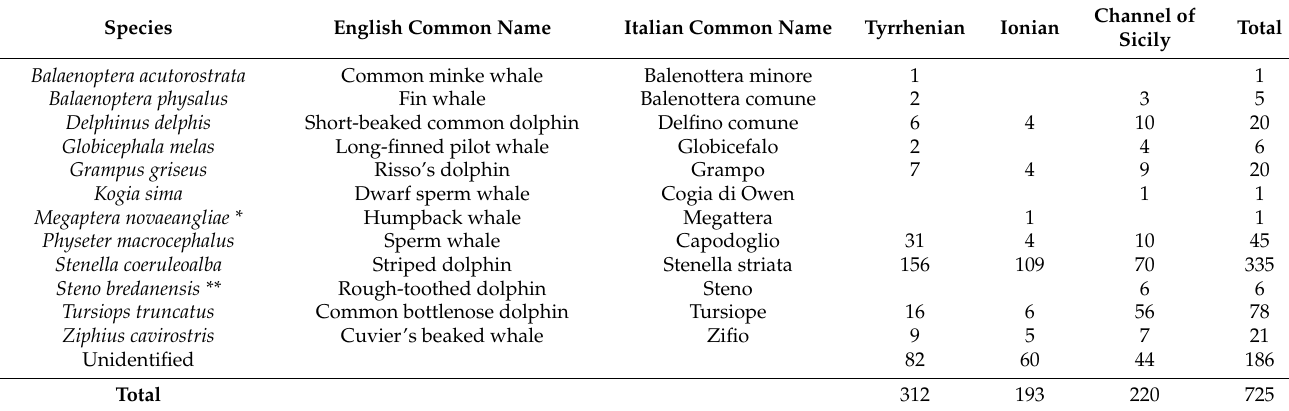
On the whole, the annual average number of stranding events is 21, calculated by eliminating the maximum value (n = 106) and the minimum value (n = 3). Stranding events showed a spatial pattern along the coast, as already detected in different seas [5–8], due to factors such as the seafloor morphology and the oceanographic characteristics. Table 2 shows the number of stranded individuals per sub-basin: Tyrrhe- nian, Ionian and Channel of Sicily. The most numerous strandings occurred in the Tyrrhe- nian sub-basin (n = 312), followed by the Channel of Sicily (n = 220), whereas the lowest number was scored in the Ionian sub-basin (n = 193). Table 2. Number of stranded and entangled specimens for each species in the different Sicilian coastal areas (Tyrrhenian, Ionian, and Channel of Sicily).